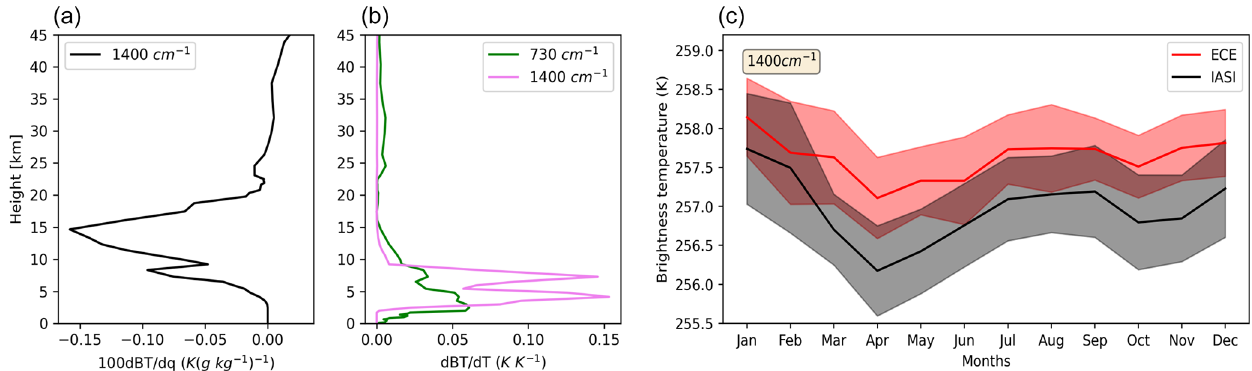
Figure 6. (a) Jacobian of water vapour integrated over the spectral band 1395–1405cm − 1 and (b) Jacobian of the temperature integrated over the spectral band 1395–1405 and 725–735cm − 1 . (c) Comparison of the brightness temperature in the spectral band centred at 1400cm − 1